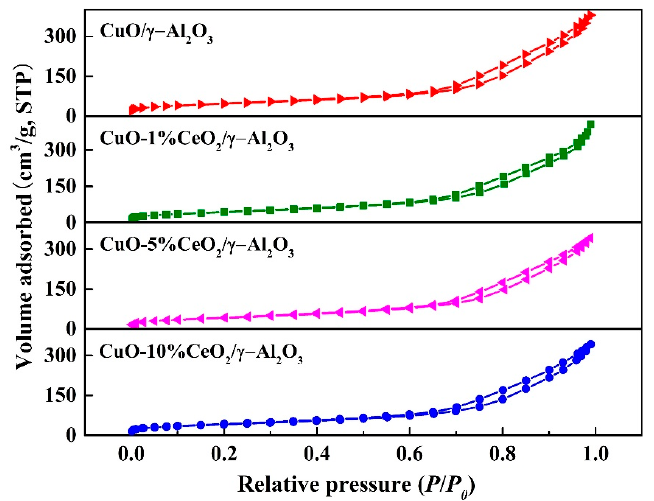
Figure 4. N 2 adsorption isotherm of CuO/ γ ‐ Al 2 O 3 , CuO ‐ 1% CeO 2 / γ ‐ Al 2 O 3 , CuO ‐ 5% CeO 2 / γ ‐ Al 2 O 3 , and CuO ‐ 10% CeO 2 / γ ‐ Al 2 O 3 .